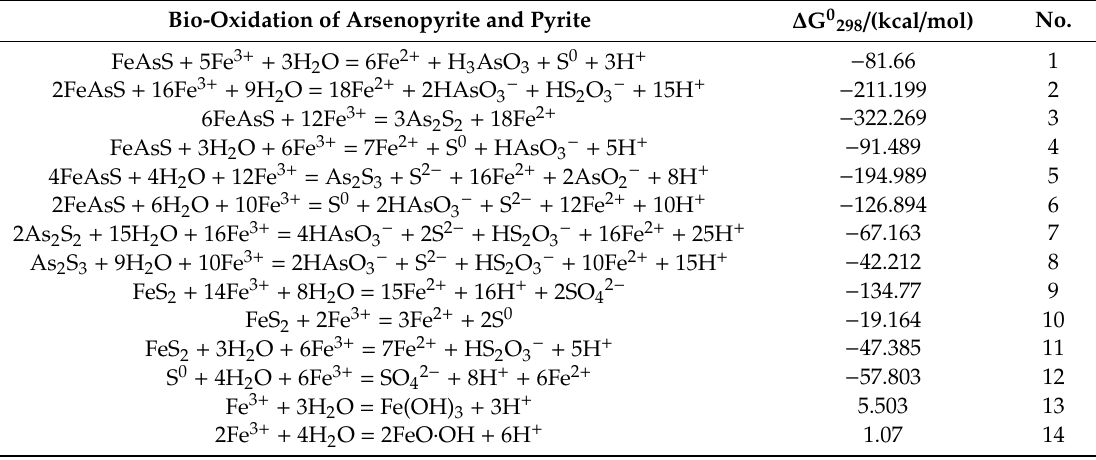
Table A1. Possible equilibrium equations involved in the bio-oxidation of arsenopyrite and pyrite. Bio-Oxidation of Arsenopyrite and Pyrite ∆ G 0 298 / (kcal /